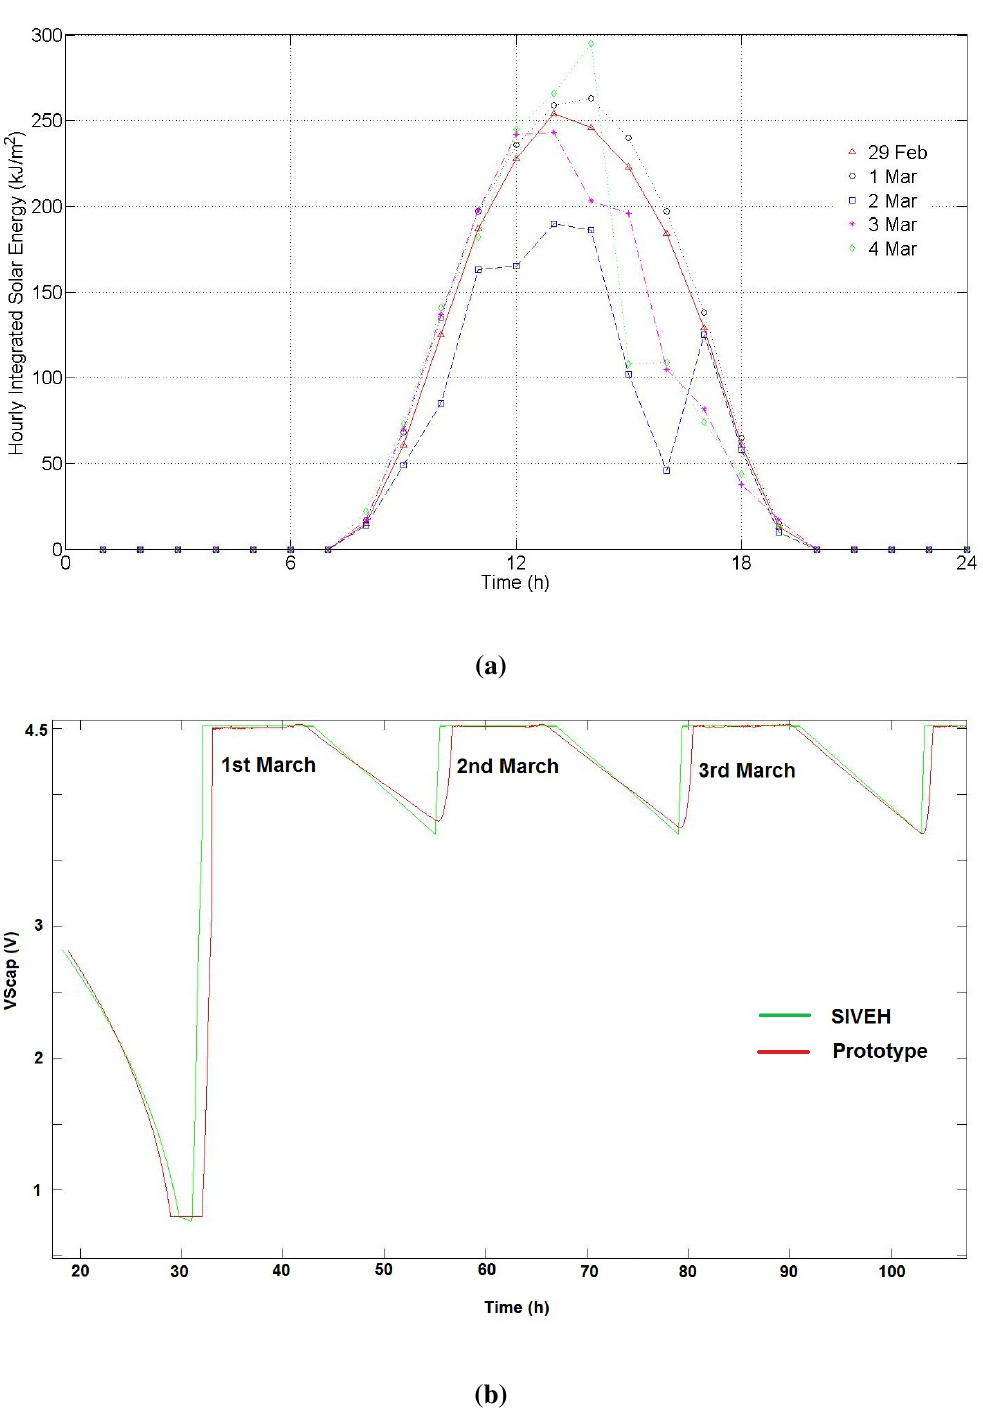
Figure 6. Four-day validation experiment. ( a ) Solar conditions from February 29 to March 1, 2012; ( b ) SIVEH predictive results vs . prototype outcomes. Four-day outdoor comparison. C = 5F ∆ t = 1